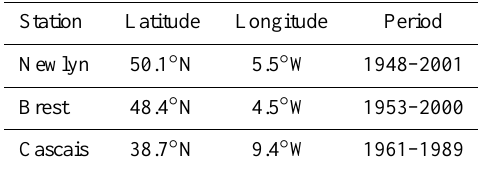
Table 1. Analysed data.